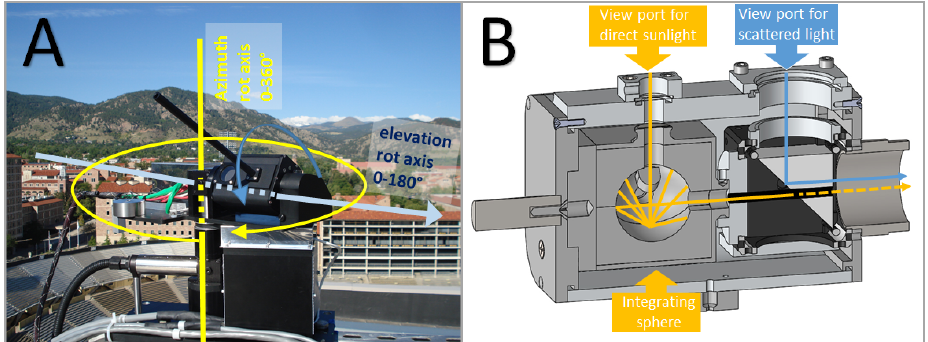
Figure 1. (a) The azimuth and elevation angle scanning (2-D) telescope. The rotation axis for the AA (yellow) and the EA (blue) are marked. (b) Sketch of the entrance optics housed by the rotating upper compartment. It contains a through-hole prism to observe scattered photons (blue line) and an integrating sphere to observe direct sunlight (orange line). Two shutters (not shown) are used to block light in one or both ports. A black anodized collimator tube (not shown) is inserted in the prism hole to avoid scattering off the edges of the prism after coming out of the integrating sphere. The lens (not shown) is located on the right side of the prism and integrating sphere. In order to avoid mechanical stress in the optical fiber and allow free mobility of the telescope, the optical fiber is attached in the lowest level of the 2-D telescope and does not